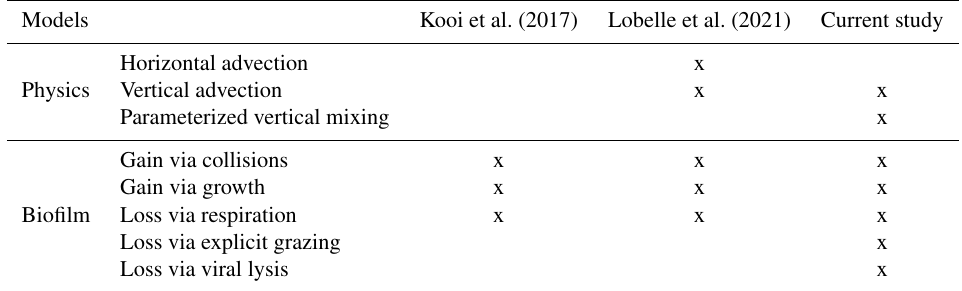
Table 1. The comparison between the modelled physical and biofilm dynamic specifications, progressing from the Kooi et al. (2017) model to the Lobelle et al. (2021) model and to the model in this study. Models Kooi et al. (2017) Lobelle et al. (2021) Current study Horizontal advection x Physics Vertical advection Parameterized vertical mixing Gain via collisions x x x Gain via growth x x x Biofilm Loss via respiration x x x Loss via explicit